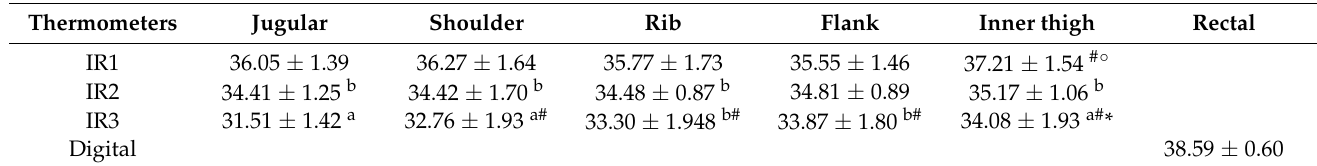
Table 2. Means ± SD of cutaneous temperature recorded in the five body regions (jugular, shoulder, rib, flank, inner thigh) obtained with the three different thermometers, and rectal temperature recorded by a digital thermometer in twenty healthy cats, expressed in ◦ C. Statistical significance is also reported. Symbols ( # = vs. jugular region, * = vs. shoulder region, ◦ = vs. rib and flank) indicate statistically differences of cutaneous temperature between the five different body regions (jugular, shoulder, rib, flank, inner thigh) using the same thermometer. Lower letters ( a = vs. IR1 and IR2, b = vs. IR1) indicate statistically different cutaneous temperature values recorded in the same cutaneous region using different thermometers (IR1, IR2,